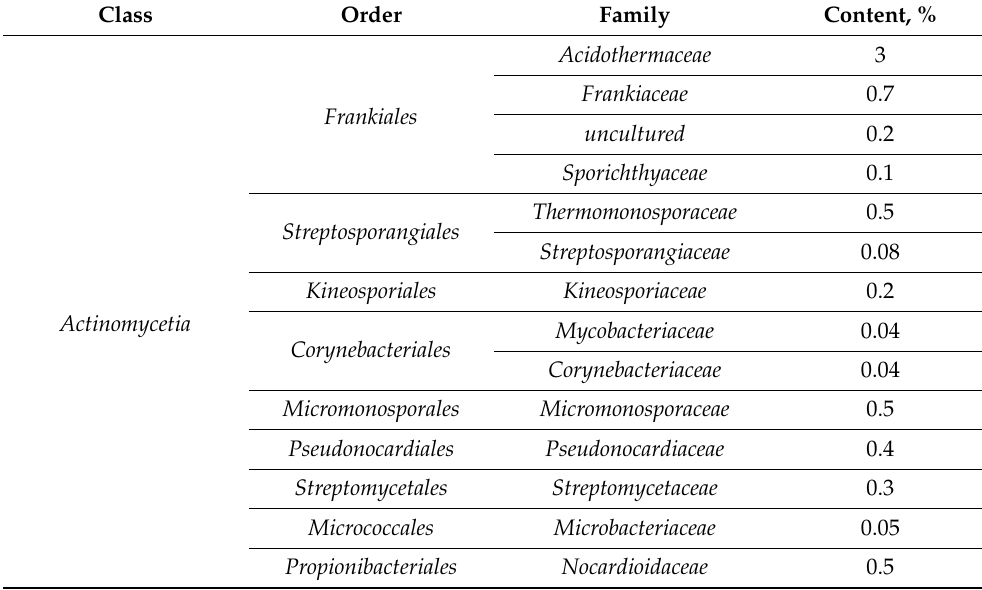
Table 6. Representation of taxa of the phylum Actinobacteriota in soil from epiphyte